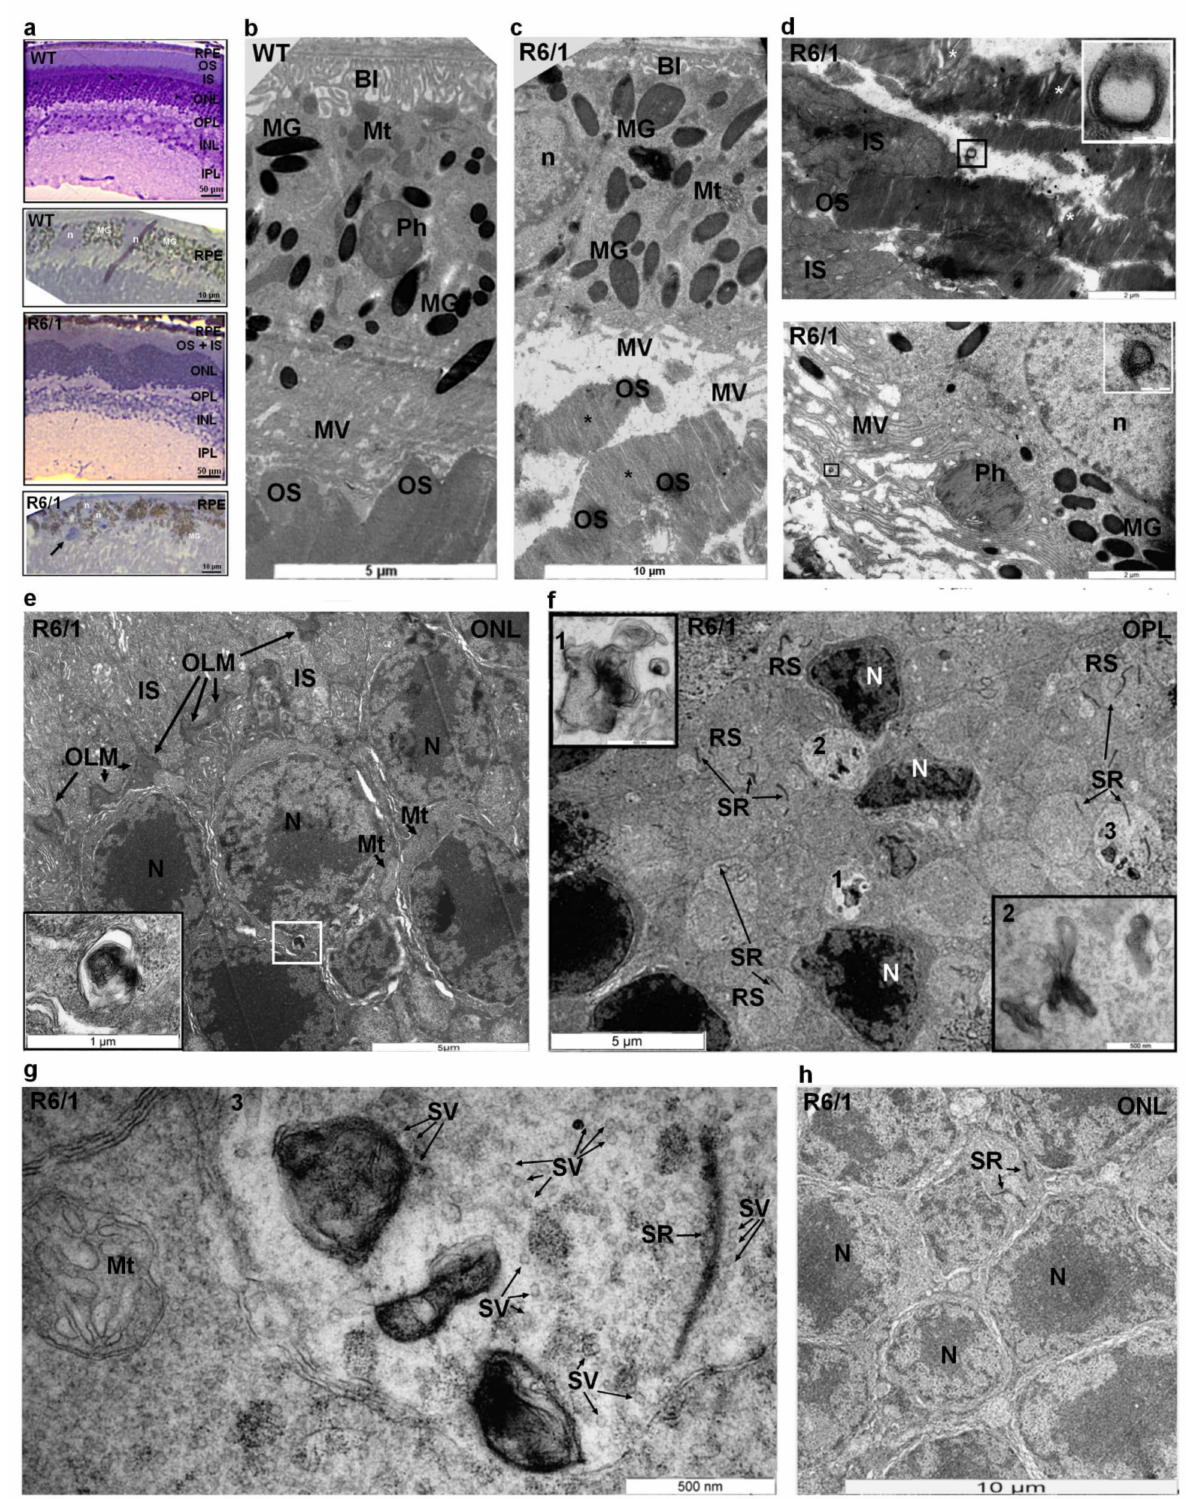
Figure 1. EM analysis of the outer retina of HD R6/1 mice. ( a ) Histological sections of eyes from 23-week-old normal and R6/1 mice. The two top panels are the sections of retina and RPE from normal mice, the two bottom panels are the sections of retina and RPE from R6/1 mice. Note the wavy aspect of the outer nuclear layer (ONL), disorganization of